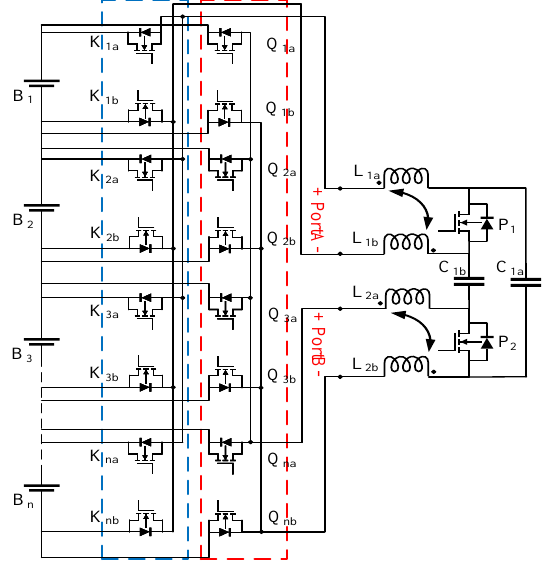
Figure 2. Internal structure of the